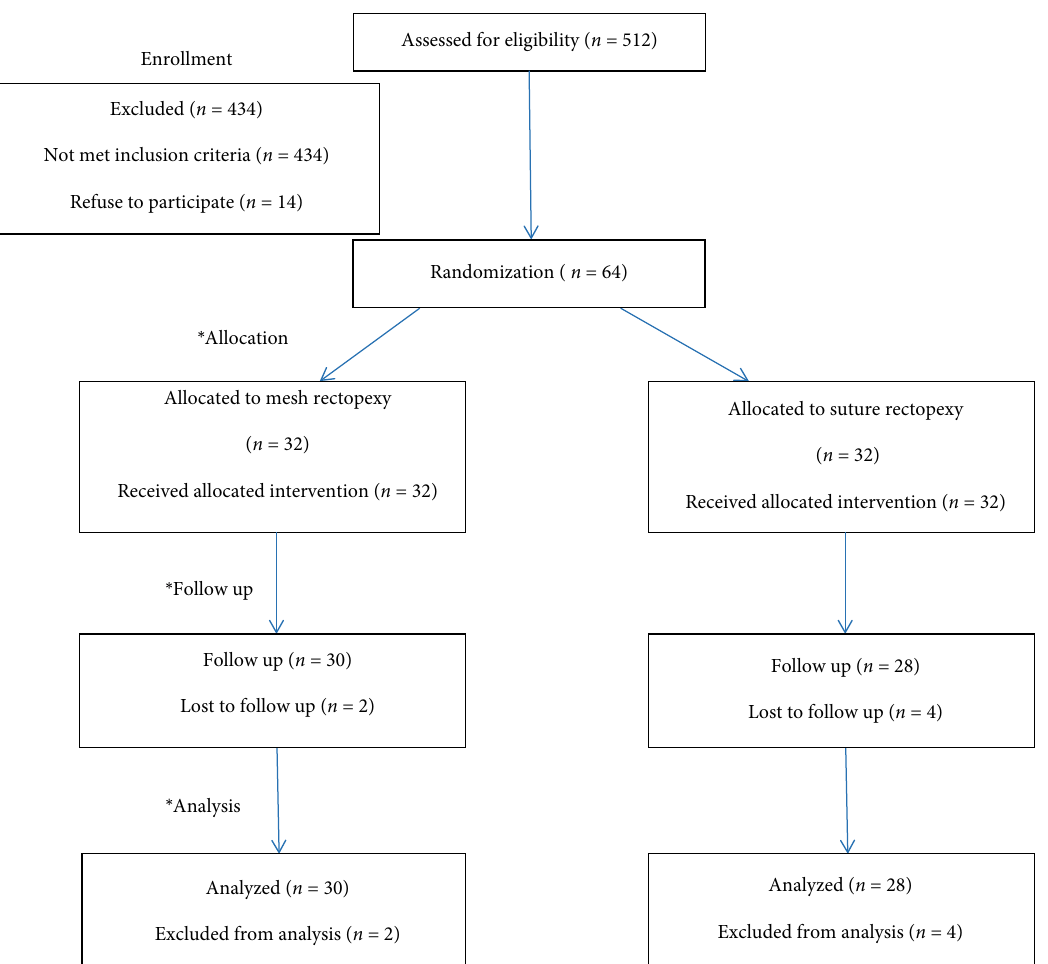
Figure 1: Algorithm of randomization trail. (i.e., enrollment, allocation, follow up and analysis of